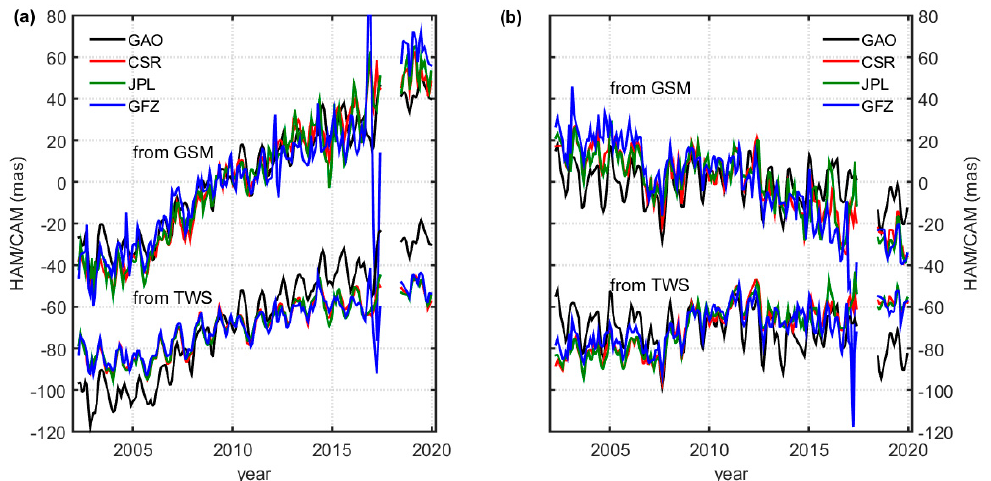
Figure 1. Time series of ( a ) χ 1 and ( b ) χ 2 components of hydrological polar motion excitation and cryospheric polar motion excitation (HAM/CAM) computed from the Gravity Recovery and Climate Experiment (GRACE) and GRACE Follow-On (GRACE-FO) monthly solutions from official GRACE/GRACE-FO processing centers at Center for Space Research (CSR), Jet Propulsion Laboratory (JPL), and GeoForschungsZentrum (GFZ). Level-2 data (GSM) and Level-3 data (terrestrial water storage (TWS)) are considered. Time series for geodetic residuals (GAO) are added for comparison. The offset value between Δ C 21 , Δ S 21 coefficients of geopotential (GRACE/GRACE-FO Level-2 data (GSM)-based HAM/CAM and TWS-based HAM/CAM time series, used for better data visibility, is 70 mas.